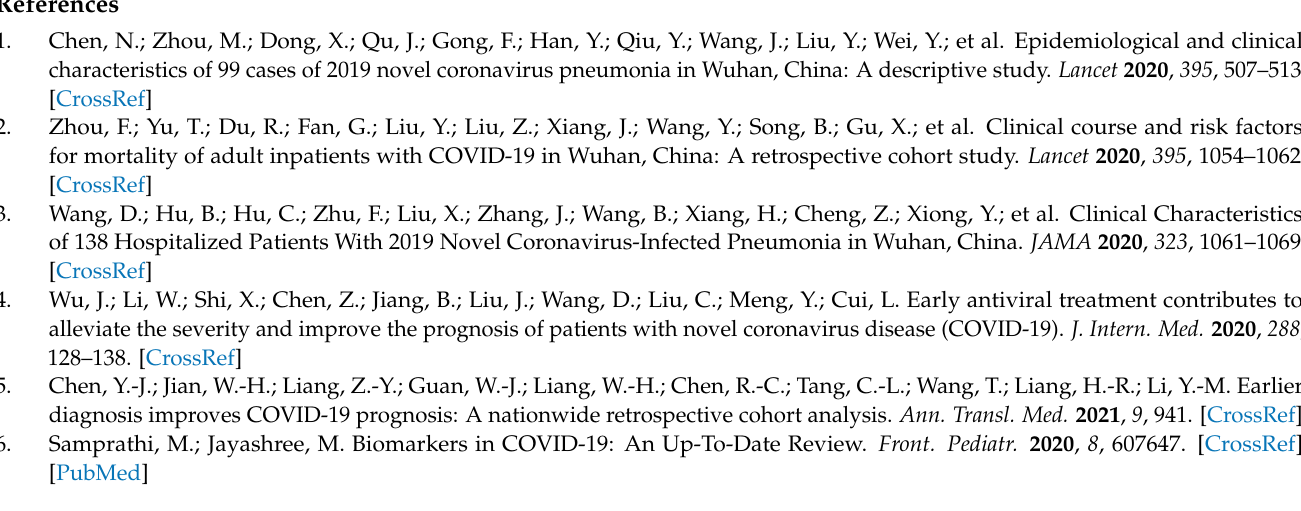
miRNAs, Table S3: Validation results for all significant miRNAs. Supplementary Figures: Leave-one- out Mendelian randomization for all candidate miRNAs before quality assessment by phenotype groups (26